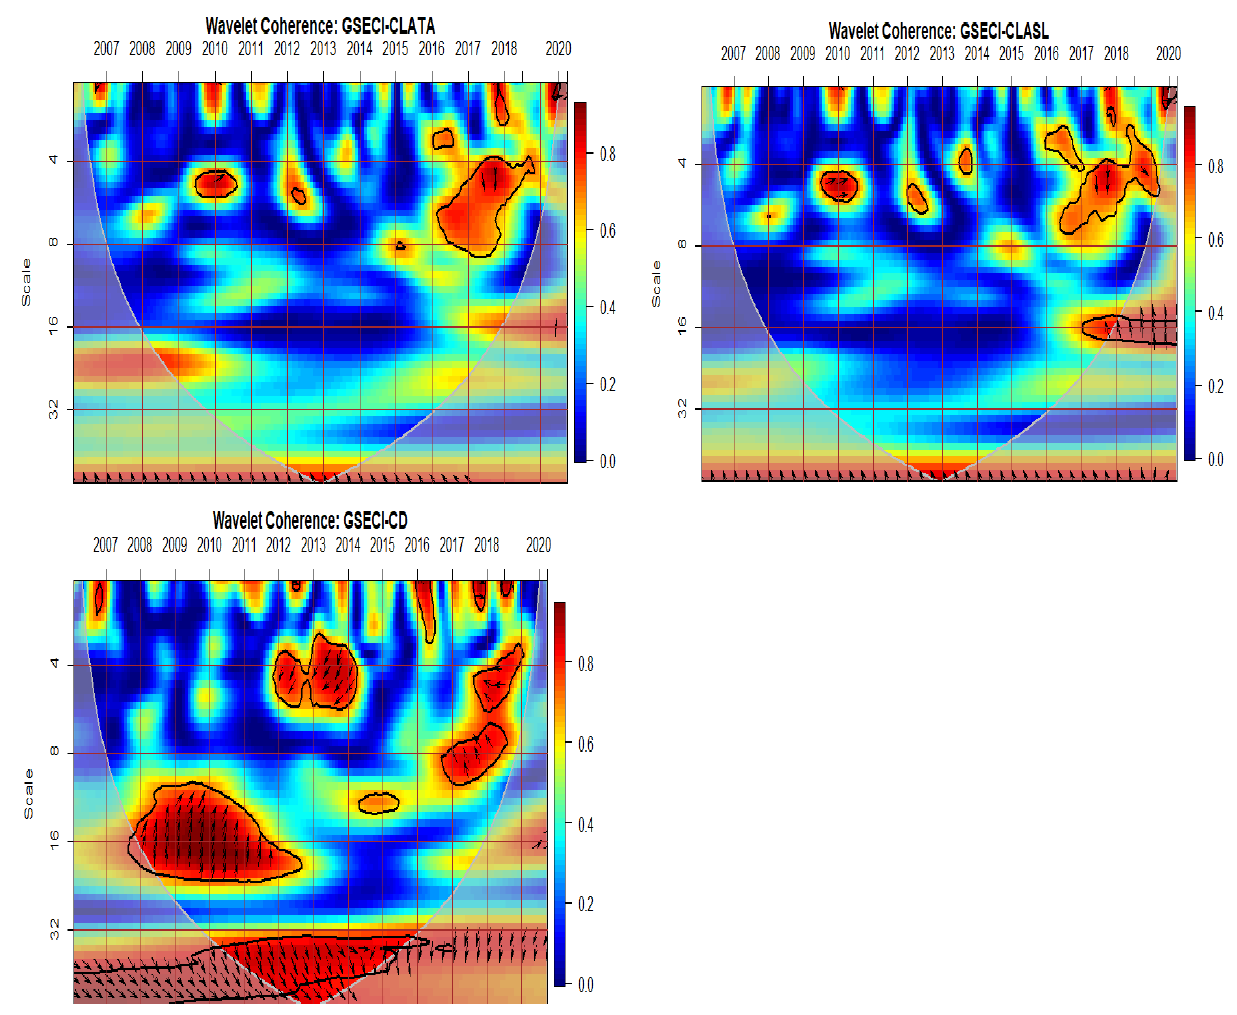
Figure 6. Comovements between GSECPI and banking sector financial soundness.